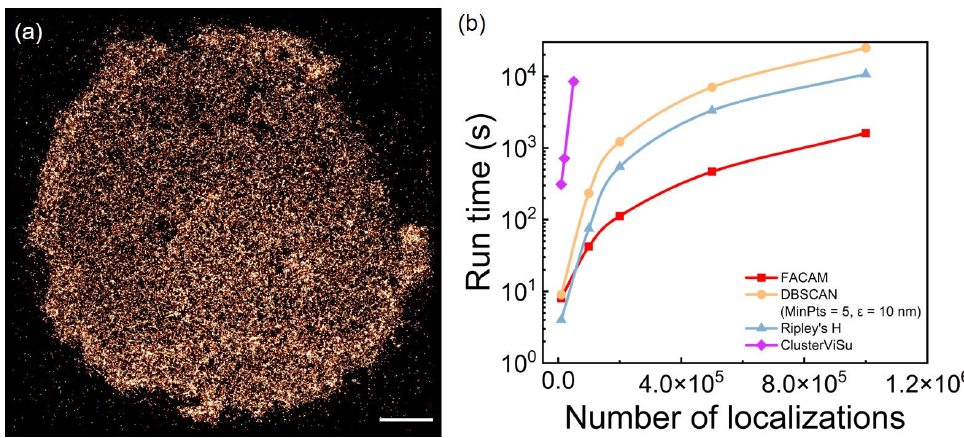
Figure 5. The dependence of computation time on the number of localizations. ( a ) The reconstructed super-resolution images of CD138. ( b ) Comparison of computation speed between FACAM, DBSCAN, ClusterViSu, and Ripley’s H function. Note that the vertical coordinates are logarithmic (base 10). Table 1. The computation time of different clustering algorithms at different numbers of localizations. Number